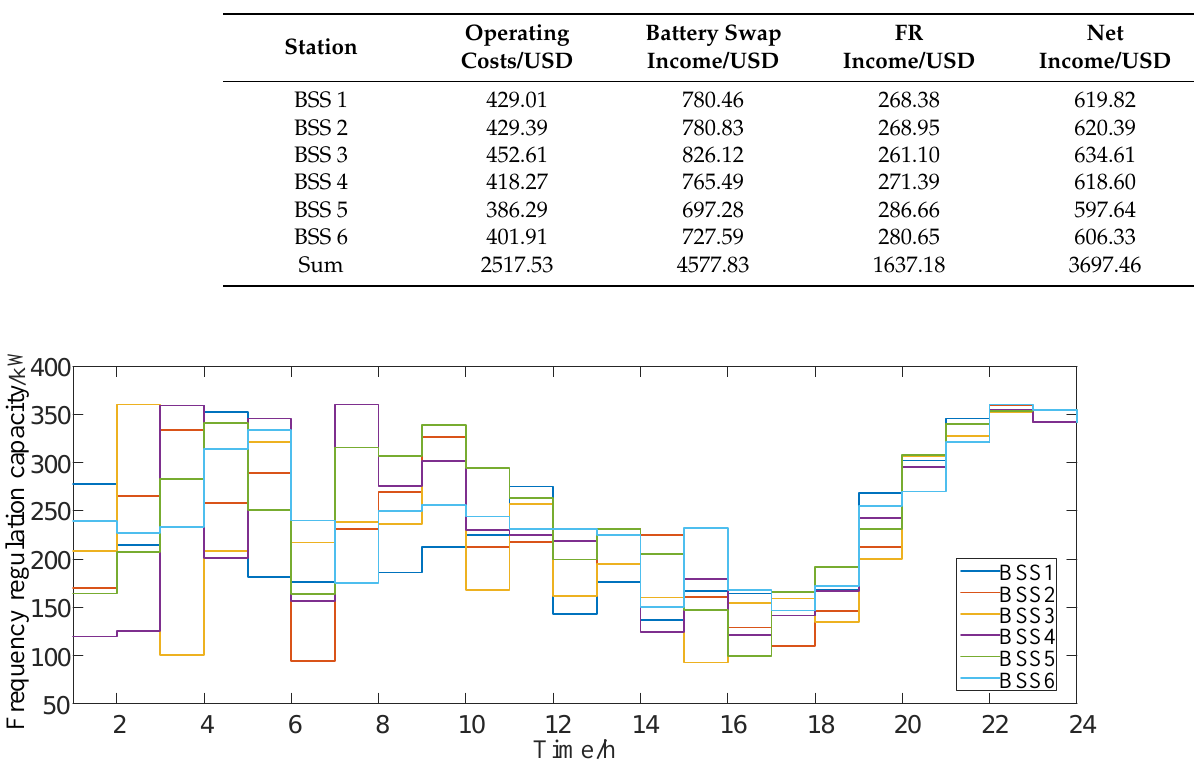
Table 3. Daily revenue under the day-ahead operating strategy.